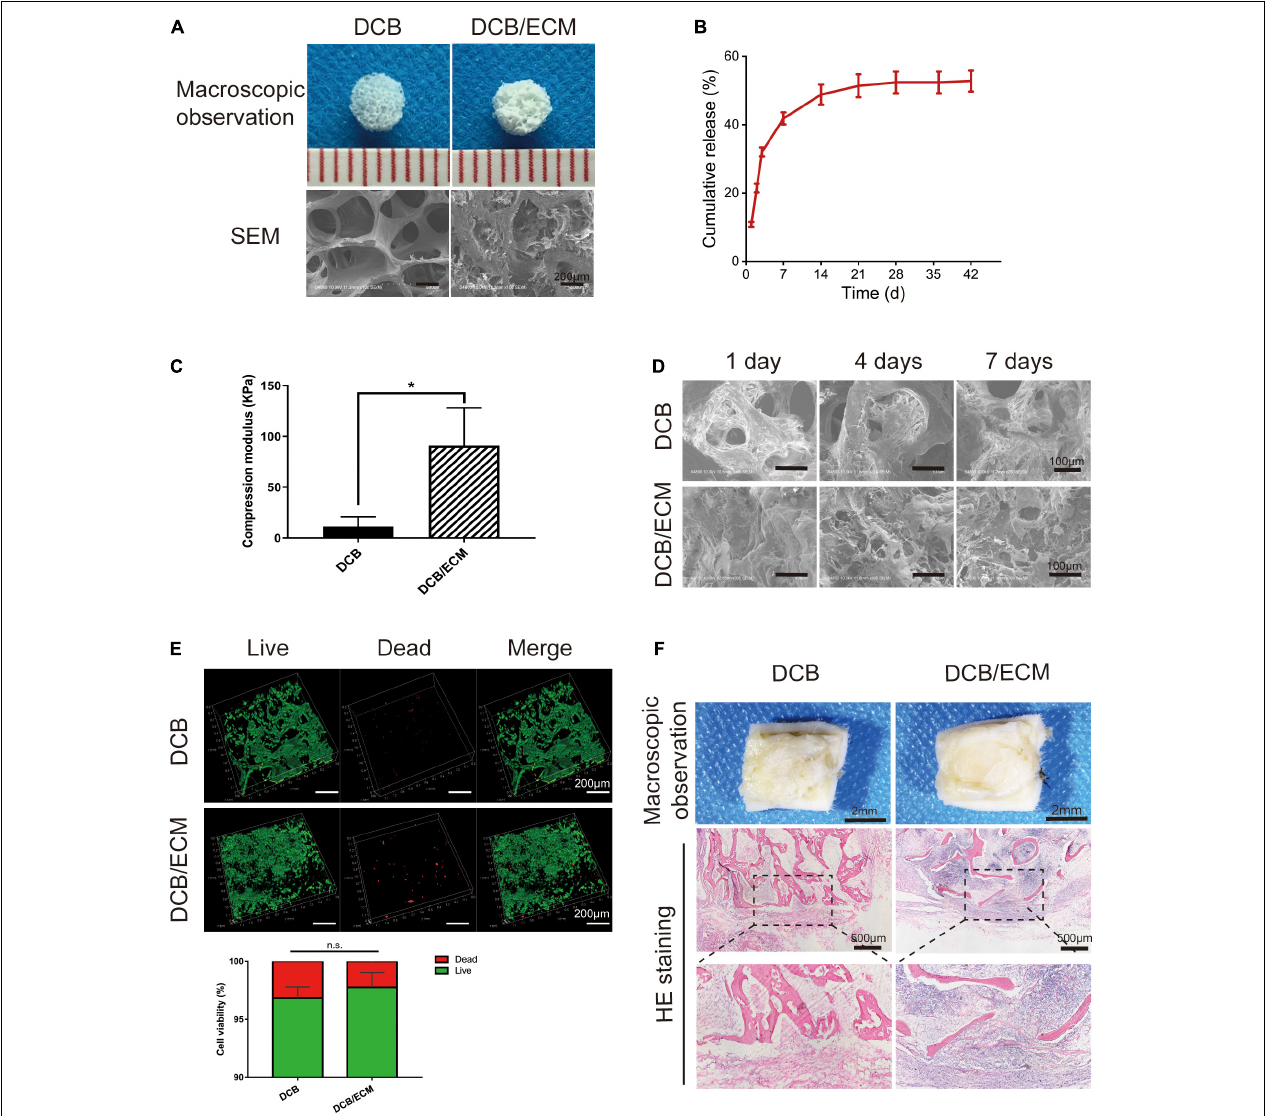
FIGURE 4 | The physicochemical, biocompatibility, and immunogenicity properties of DCB and DCB/ECM scaffolds. (A) Macroscopic features and SEM of DCB and DCB/ECM scaffolds. (B) TGF- β 3 release kinetics of the DCB/ECM/TGF- β 3 scaffold. Values are presented as the means ± SDs ( n = 3). (C) Compression modulus of DCB and DCB/ECM (scaffolds; values are presented as the means ± SD, n = 5). (D) SEM of DCB and DCB/ECM scaffolds on which IPFSCs were seeded for 1, 4, and 7 days. (E) Live/dead staining analysis of IPFSCs cultured in DCB and DCB/ECM scaffolds for 7 days. Representative 3D reconstruction images show live (green) cells and dead (red) cells. Values are presented as the means ± SDs ( n = 3). (* p < 0.05, n.s. represents no significant difference). (F) Macroscopic observations and H&E staining of the immune responses of DCB and DCB/ECM scaffolds at 1-week postimplantation in